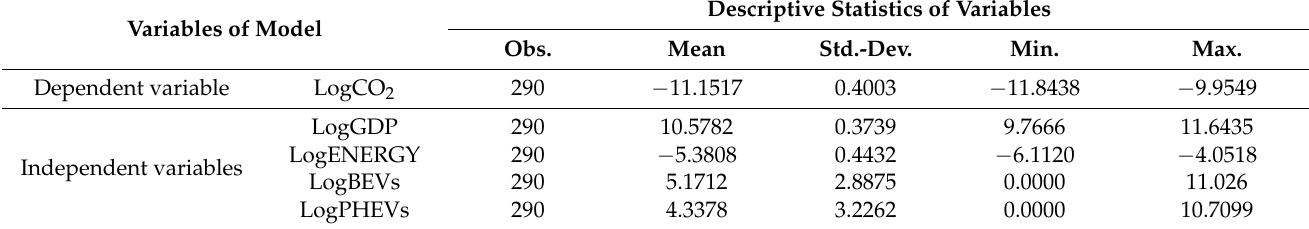
Table 2. Descriptive statistics of variables.